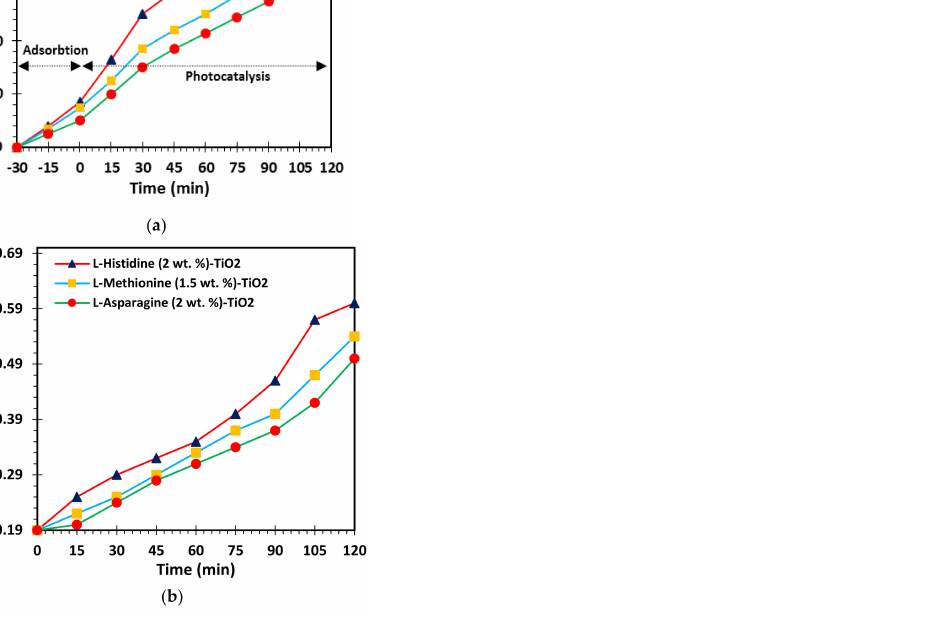
Figure 3. Photocatalytic performance of optimum L-Amino acid-TiO 2 in ( a ) COD removal and ( b ) BOD 5 /COD ratio versus irradiation time at catalyst loading of 2 g/L, COD concentration of 500 mg/L and original pH = 5.7.